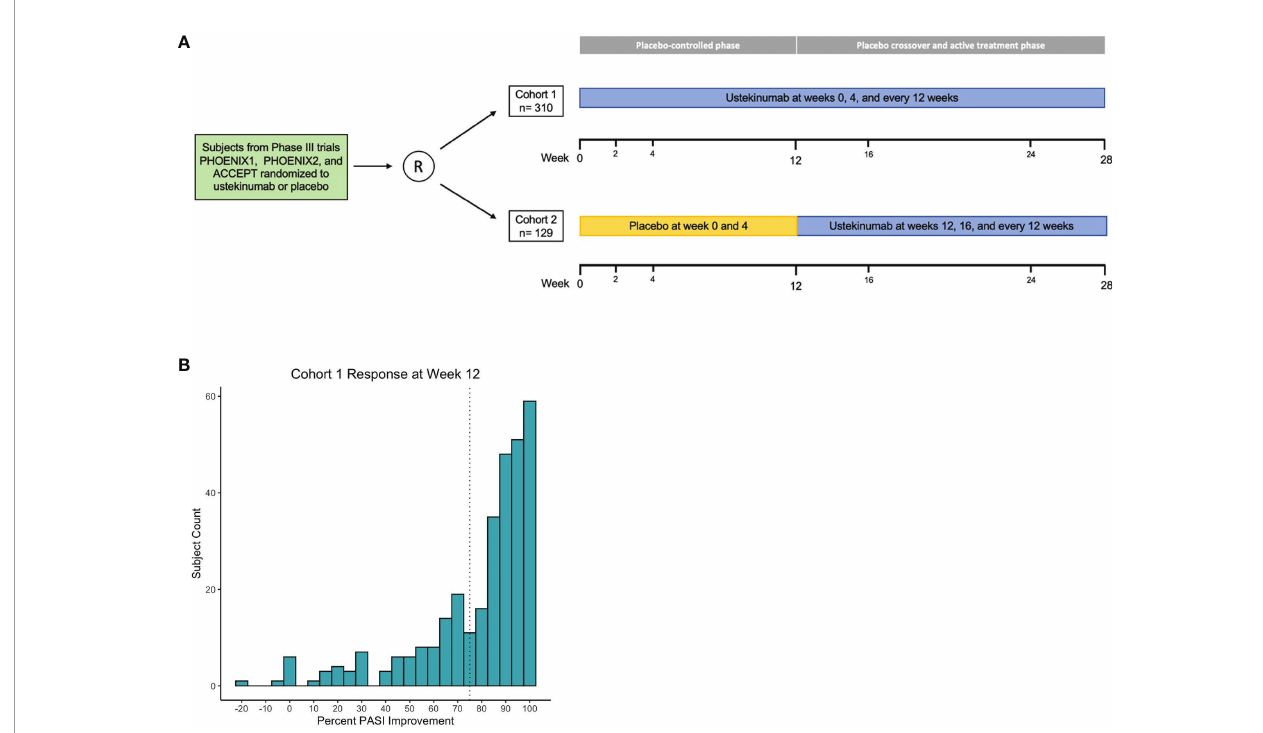
FIGURE 1 | Association analysis design and primary outcome. Phase 3 clinical trial comprise discovery and validation cohorts (A) . Histogram of cohort 1 percent PASI improvement at week 12; dashed line marks 75% improvement threshold (B)